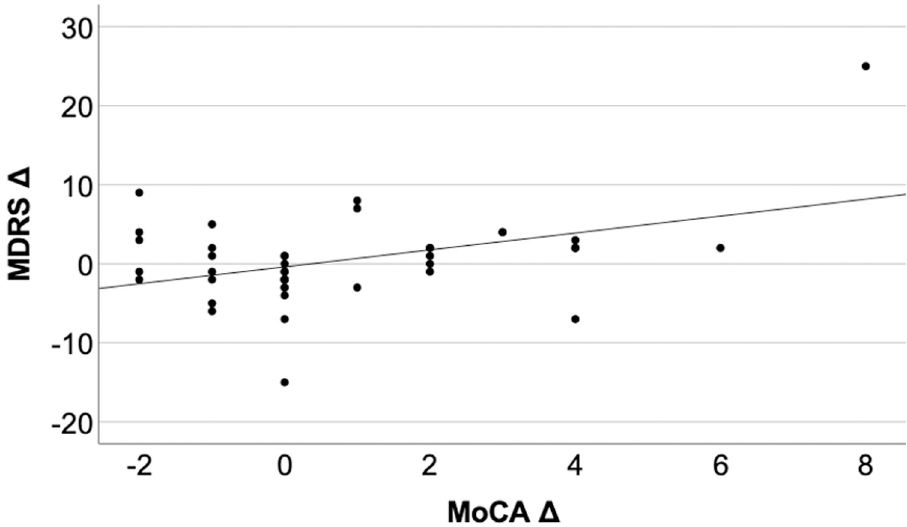
Fig 2. Linear regression of pre- and postoperative changes of MoCA and MDRS. Scatterplot of Δ MoCA and Δ MDRS as dependent variable with linear regression slope of 1.07 points (p = 0.006) but weak model prediction. MoCA Δ , preoperative-postoperative MoCA; MDRS Δ , preoperative-postoperative MoCA.